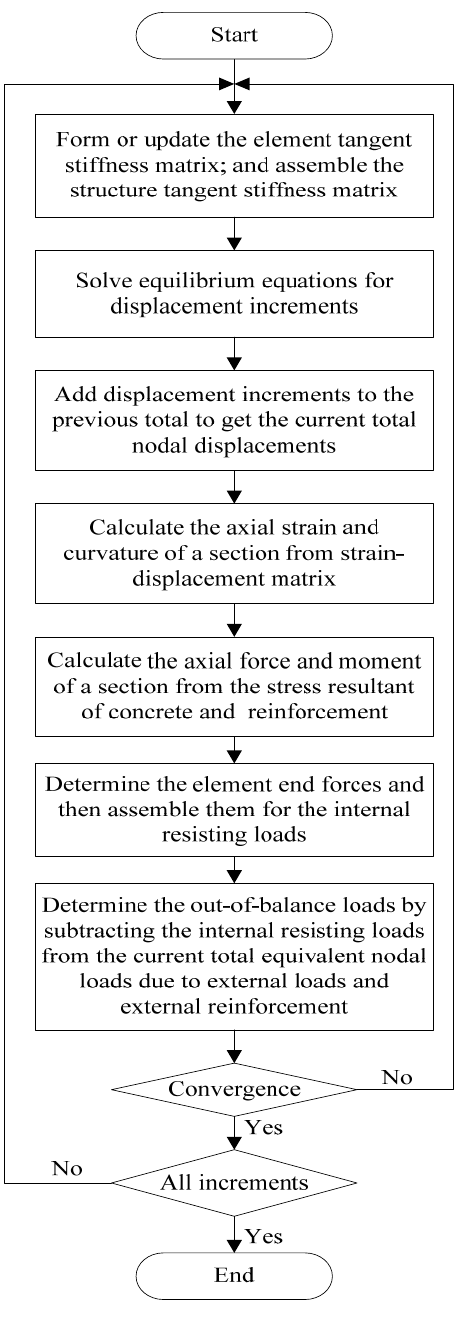
Figure 1. Flowchart of numerical algorithm.